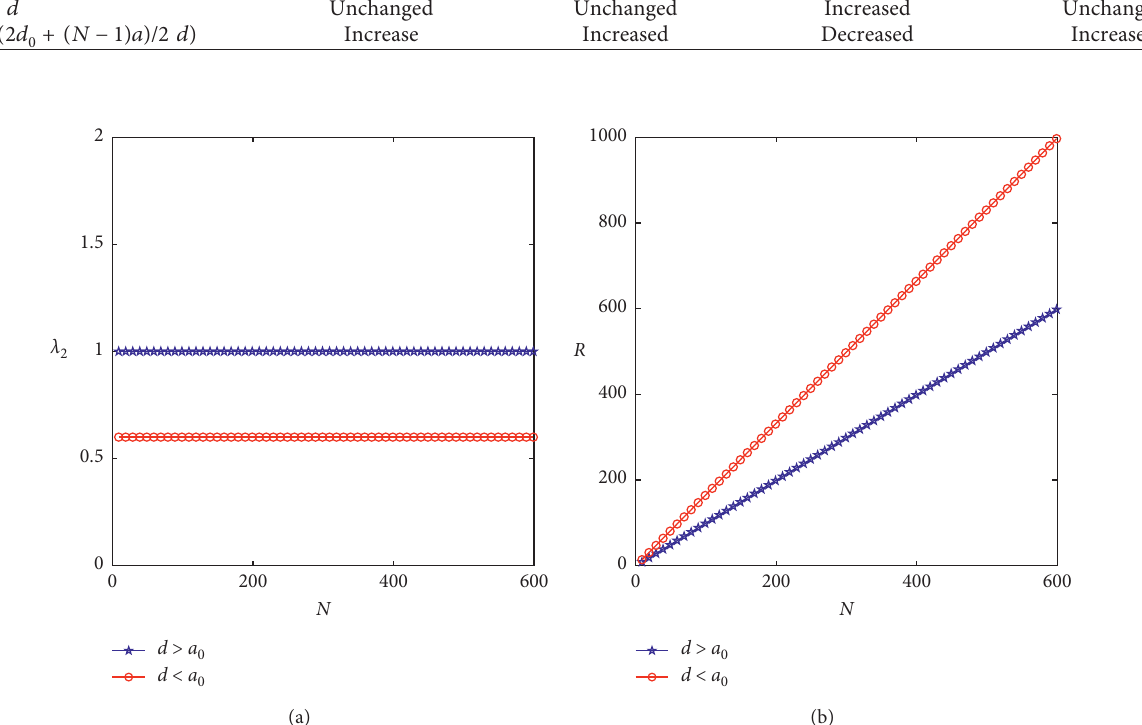
Table 7: The change of λ and R with N, a,d, and d 2 Increase of N